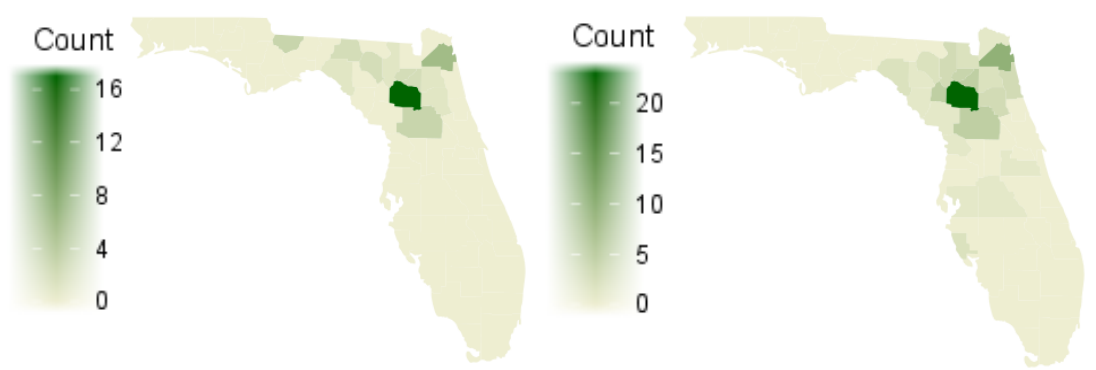
Summed Network Diagram of Communication Among Actors